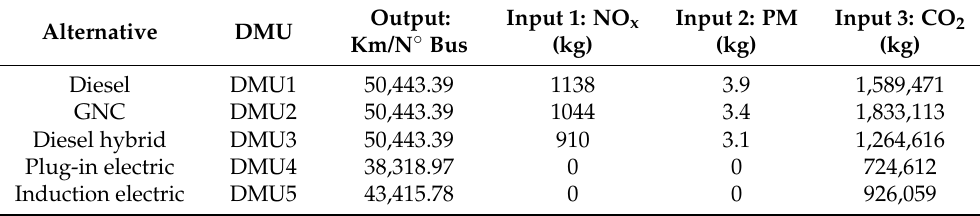
Table 2. Data used in the